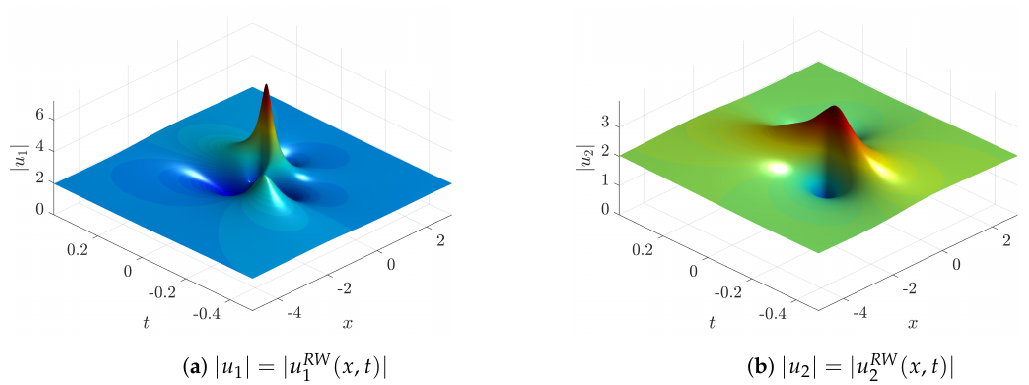
Figure 15. RW solutions corresponding to a triple eigenvalue w 1 = w 2 = w 3 = − 1/3 λ c of the matrix W ( λ ) in Equation (14). q = 1, s 1 = s 2 = − 1 (focussing), r = 0, p = − 8 ( a 1 = a 2 = 2); λ c = 3 i c = e i 7 π 4 , c 1 = e i 23 π 12 , c 2 = 1 √